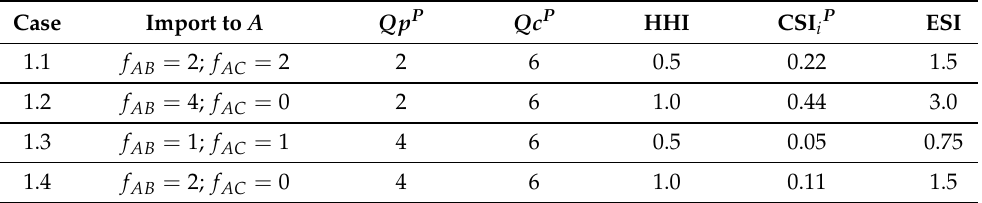
Table 1. Energy Security indexes for economy A , the case of one